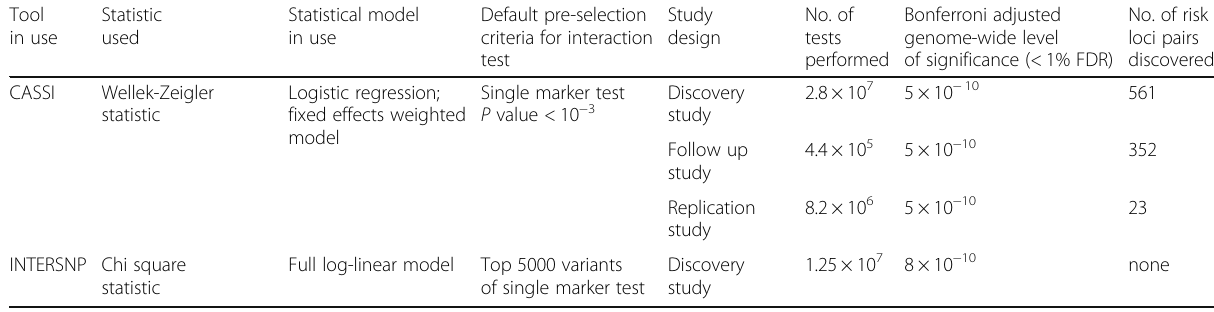
Table 1 Overview of tools and different subsequent protocols in use. Study designs enlist three stages of analysis Tool in